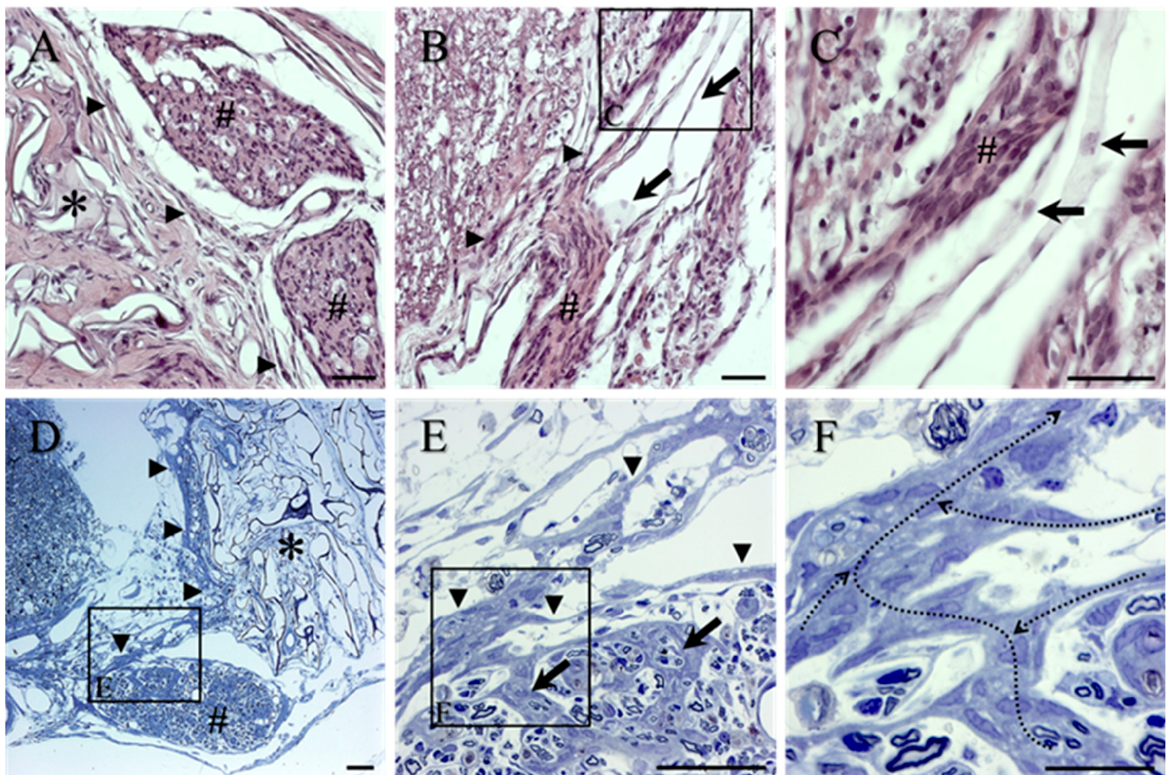
Figure 4. Morphology of reactive spinal nerve roots in transverse spinal cord sections from the collagen scaffold-implanted group stained with H&E ( A – C ) and for toluidine blue in semi-thin sections ( D – F ). ( A ) Dorsal spinal nerve roots (#) located between thin sheets of overlapping, elongated reactive cells (arrowheads) covering the outer-most surface of the implanted collagen scaffold (asterisk) and the repaired dura mater. ( B ) Pale staining of the leptomeninges (arrows, also seen at higher magnification in C). ( C ) Higher magnification of the leptomeninges (arrows) is demonstrated close to a damaged spinal nerve rootlet (#). Note the morphological differences between leptomeningeal cells and the reactive cells of the rootlet (#). ( D ) Areas of thickened, reactive perineurium that circumscribed part of a damaged ventral nerve root could be seen extending towards and along the medial edge of the implanted scaffold (arrowheads). The porous framework of the scaffold (asterisk) contains abundant deposits of lightly stained ECM. ( E ) Higher magnification of the boxed area in D. The damaged nerve root is surrounded by the overlapping cells and processes of reactive PNLC (arrowheads), which also formed the so-called septae within the damaged, reactive roots (arrows). ( F ) Higher magnification of the boxed area in E. The continuity of the reactive cells that formed the intra-spinal nerve root septae with the cells of the surrounding perineurium is indicated by the meandering dotted arrows. Scale bars: A–E = 50 µm; F = 20 µm. The ultrastructural features of the cells of the intra-nerve root septae, cell clusters, and reactive perineurium were all strikingly similar and consistent with those of perineurial cells. These PNLC features were also consistently observed in the cells along the inner lining of the dura mater of lesion-only control animals (Figure 6A,B), as well as of the transition zone (Figure 6C–F) located around the implanted scaffold, which showed signs of degradation (double black arrows, Figure 6C). In both regions, the nuclei of these reactive cell layers were predominantly ovoid in shape, all following the same orientation (white arrows, Figure 6A,C,D). The PNLC features were also present in the cells of isolated clusters, close to the transition zone or even associated with blood vessels (Figure